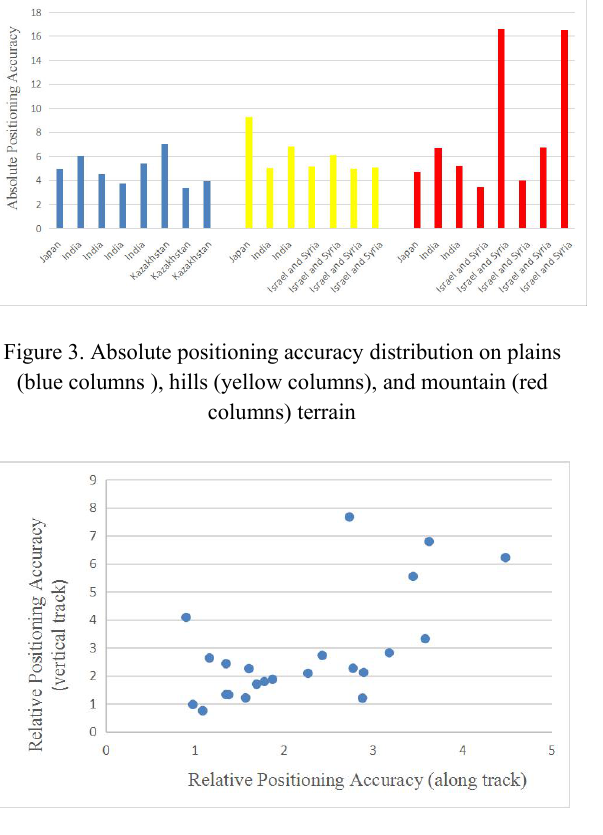
Figure 4. Spatial distribution of relative positioning accuracy in GE’s